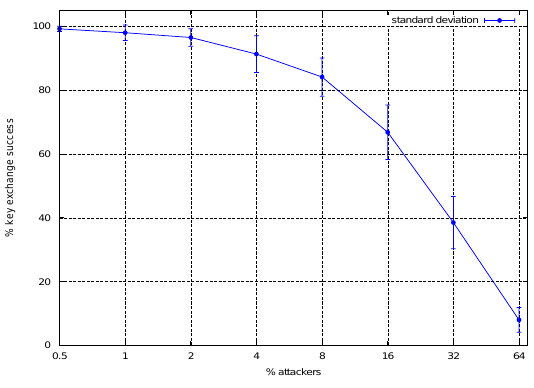
Figure 14. Standard deviation in the BGP-4 network map